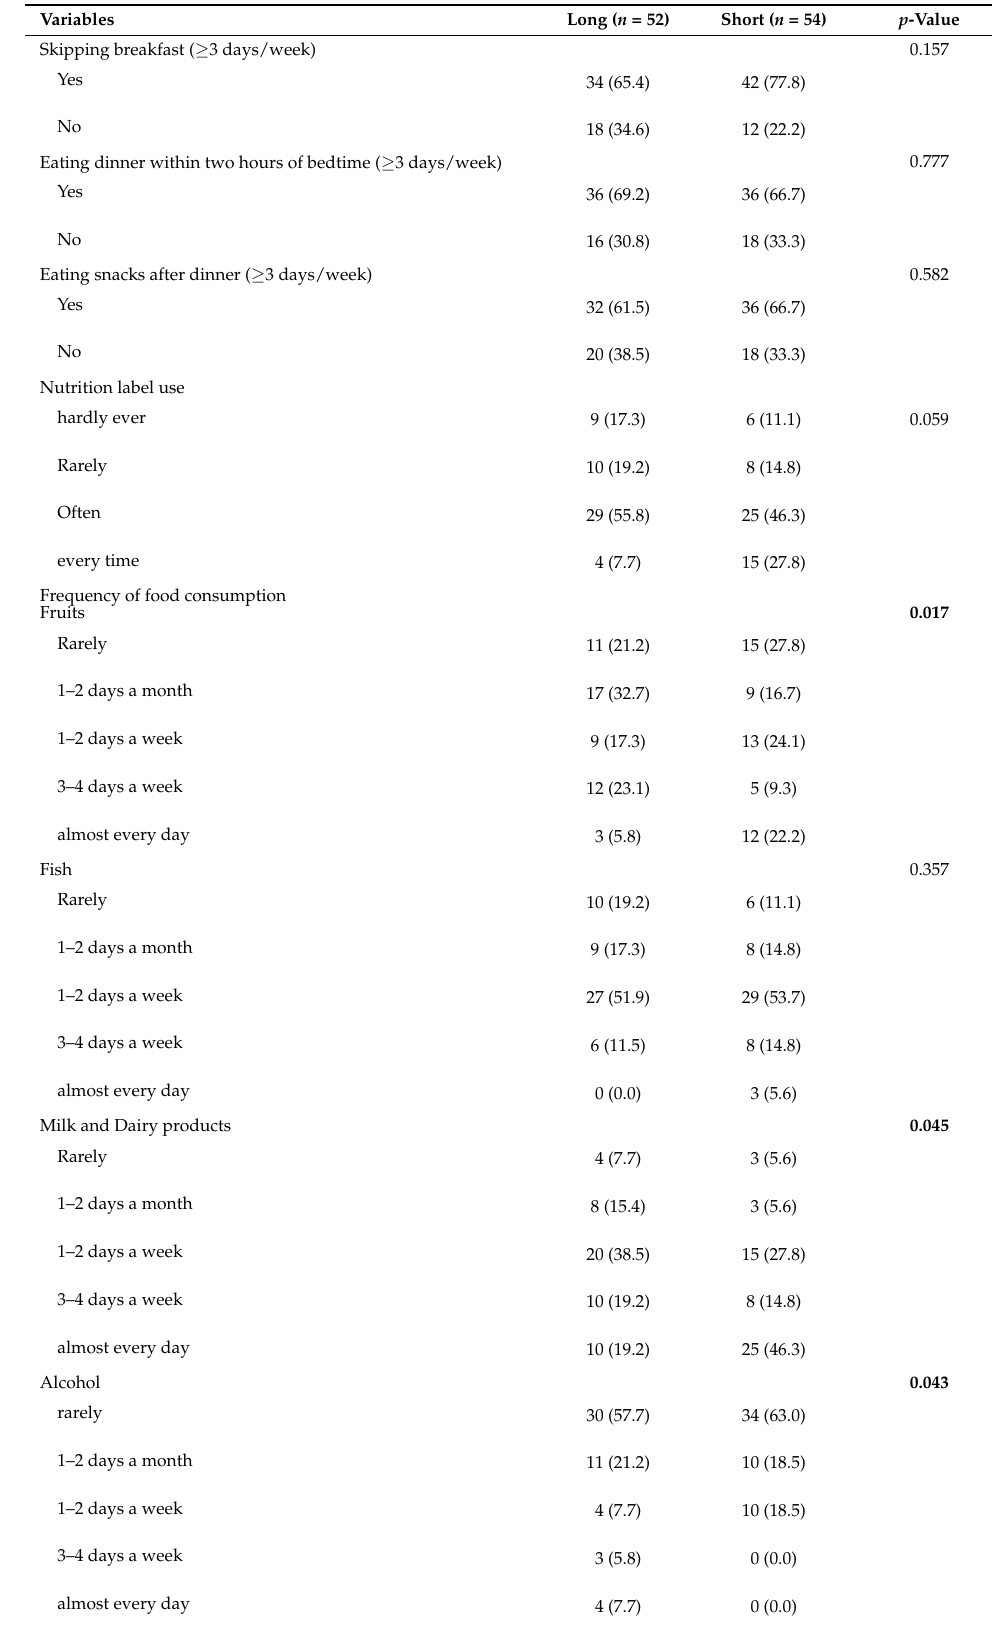
Table 2. Eating behaviors by the duration of SNS